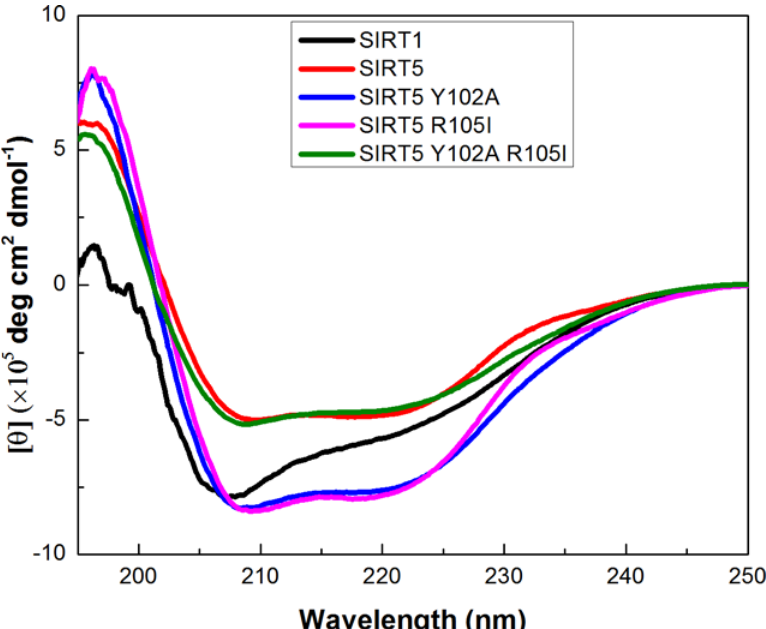
Fig 3. Circular Dichroim (CD) Spectra of SIRT5 Variants and SIRT1. The mean residue ellipticities of 10 μ M enzymes as a function of wavelength are shown. The experiments were performed in 5 mM Tris-HCl buffer, pH 7.5 using a quartz cuvette of 1 mm path